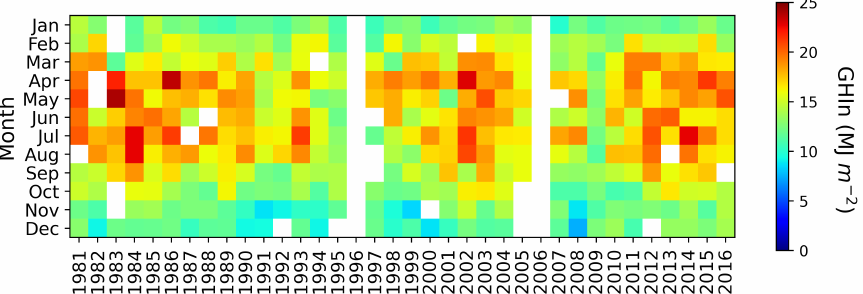
Figure 6. Monthly mean global solar insolation (GHIn, in MJ m − 2 per day) for each year during the measured period, from